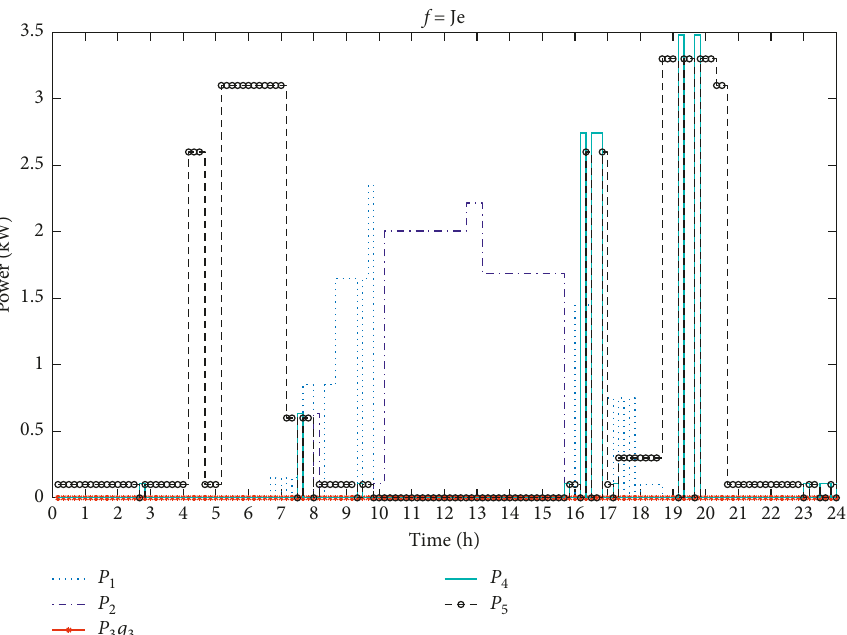
Figure 4: Power dispatch of the previous design in case